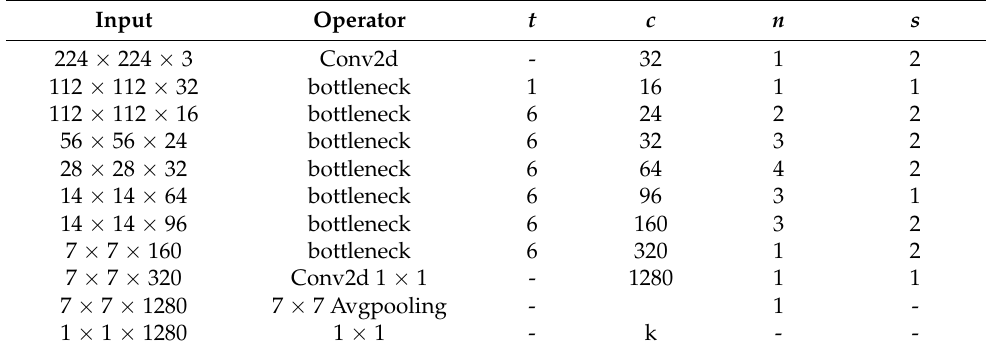
Table 1. MobileNetV2 network architecture.